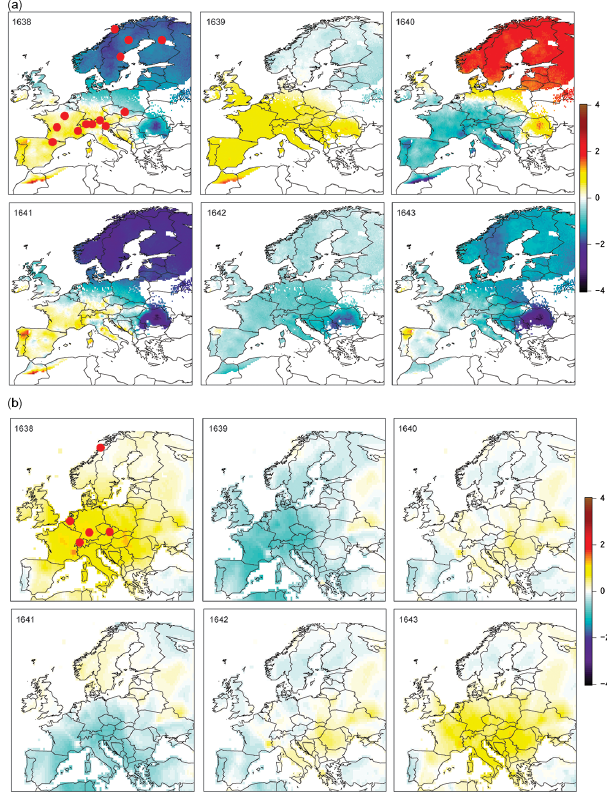
Figure 6. Summer (JJA) temperature anomalies over Europe be- tween 1638 and 1643 as derived from (a) a network of 12 tree-ring width, maximum latewood density, and stable isotope chronologies and (b) the Luterbacher et al. (2004) dataset. Temperatures are ex- pressed as departures from summer (JJA) mean using a moving 31- year time window. Red dots denote the origin of the proxies used in either of the